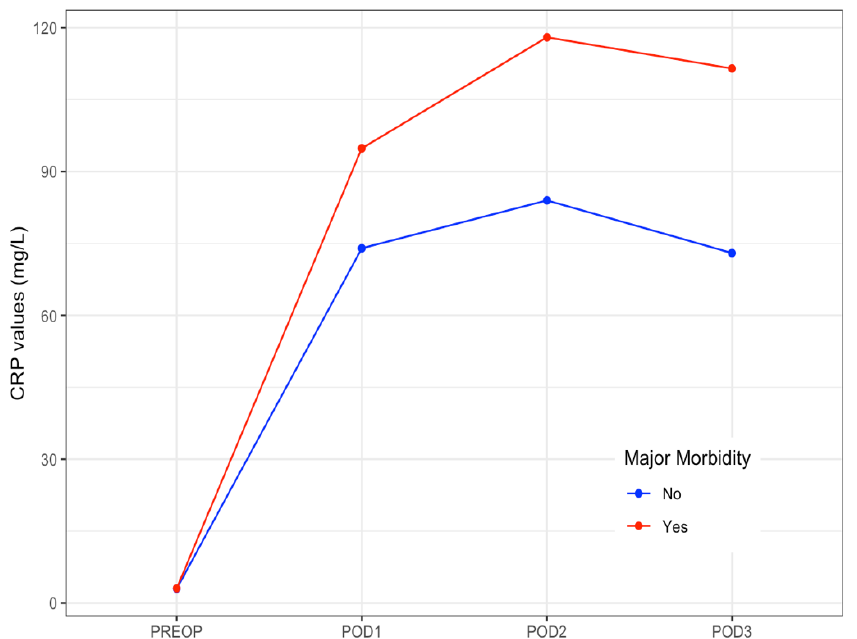
Figure 1. Daily median levels of CRP in patients with and without postoperative major morbidity. Evolution at the early postoperative period. CRP: C-Reactive Protein. PREOP: Preoperative. POD: postoperative day.